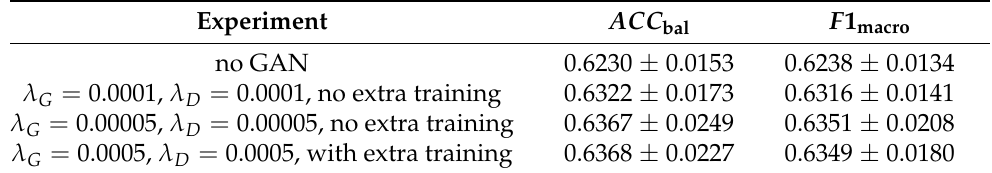
Table 7. Experiments for the synthetic augmentation of the training dataset with the TransfGAN.